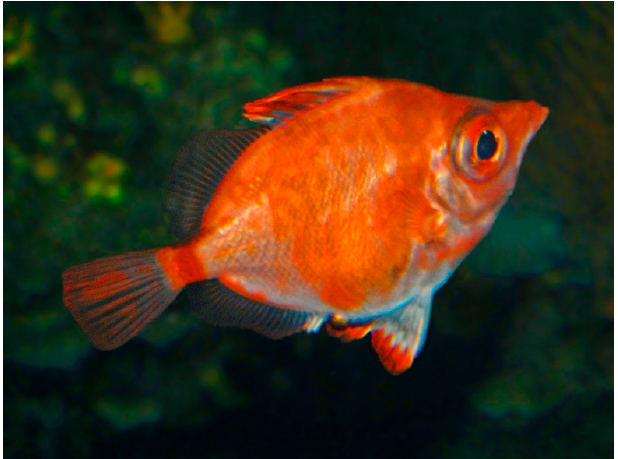
Figure 1. Boarfish ( Capros aper ) [9].